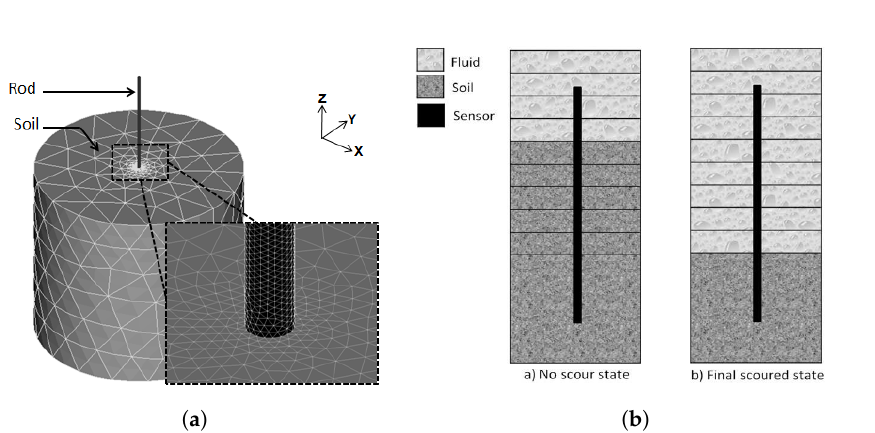
Figure 3. Finite elements scour model. ( a ) Three-dimensional numerical model of the rod-soil system and mesh details; ( b ) Scour simulation with the numerical